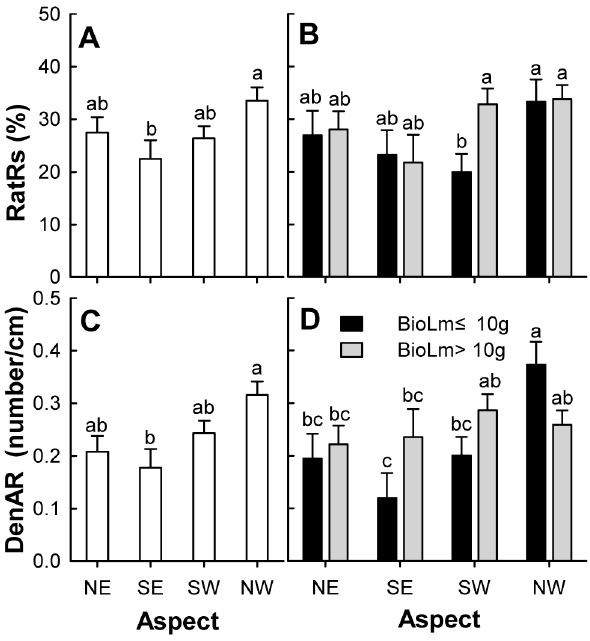
Figure 2. Effects of aspect and size class of layering module on clonal reproduction of Nitraria tangutorum . RatRs and DenAR represent the rate of ramet sprouting (%) (A and B)and density of adventitious root formation points (number/cm) (C and D), respectively. BioLm represents the layering biomass; Open bars (A and C) are grand means of four aspect sections across two size classes of layering. Grayscale bars (B and D) are means of the four aspect sections and two size classes of layering; the error bars represent standard errors of the means; the letters above the error bar are the groupings from Duncan’s multiple range tests. Bars followed by different letters are significantly